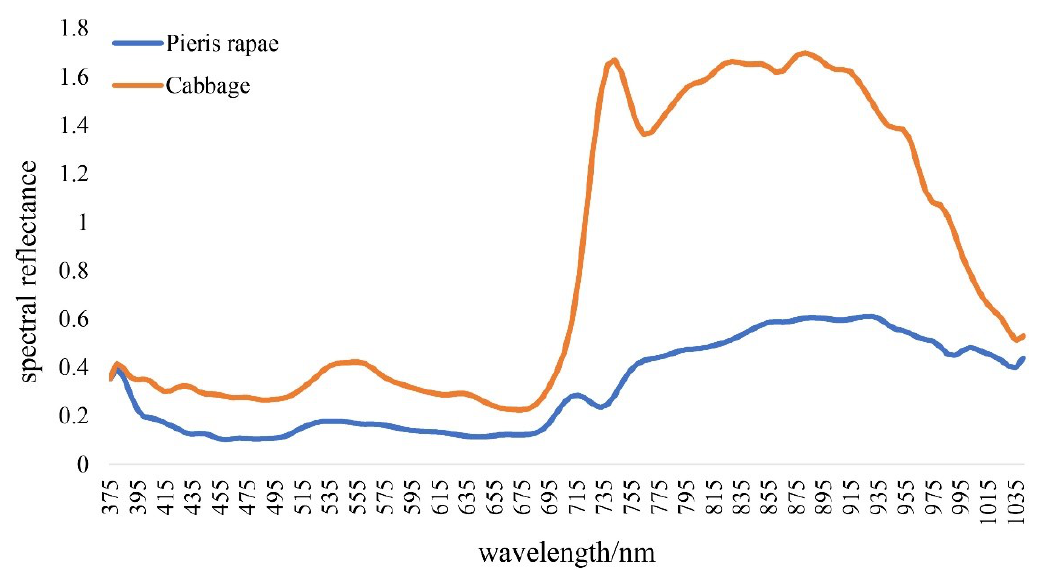
Figure 7. Comparison curve of average spectral characteristics between cabbage and Pieris rapae .